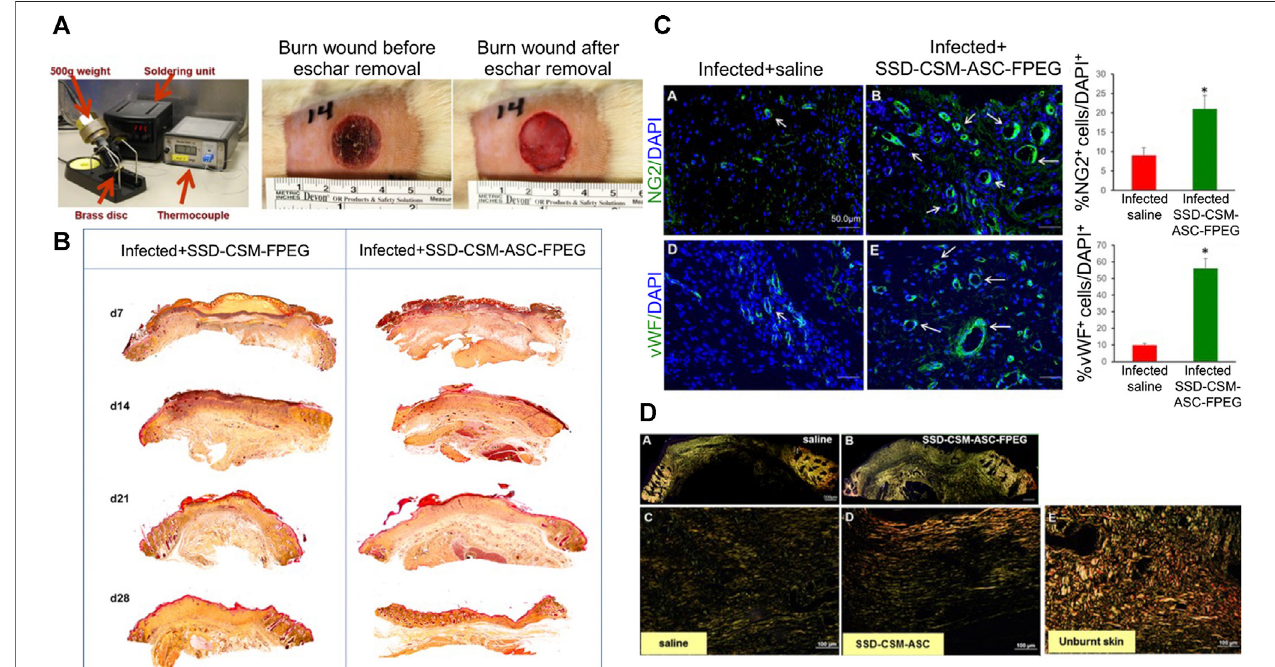
FIGURE6 | Deliveryof silver sulfadiazine and adipose-derived stemcells using fi brinhydrogel improves infected burn wounds. (A) Photographs ofthe burn device and burn wound. (B) Burn wounds treated with SSD-CSM-ASC-FPEG had signi fi cantly thicker granulation tissue than those treated with SSD-CSM-FPEG. (C) SSD- CSM-ASC-FPEG facilitates neo-vascularization on day-21. p < 0.05. (D) Maturation of collagen. Picrosirius staining images on day-28. Reproduced with permission from (Banerjee et al.,